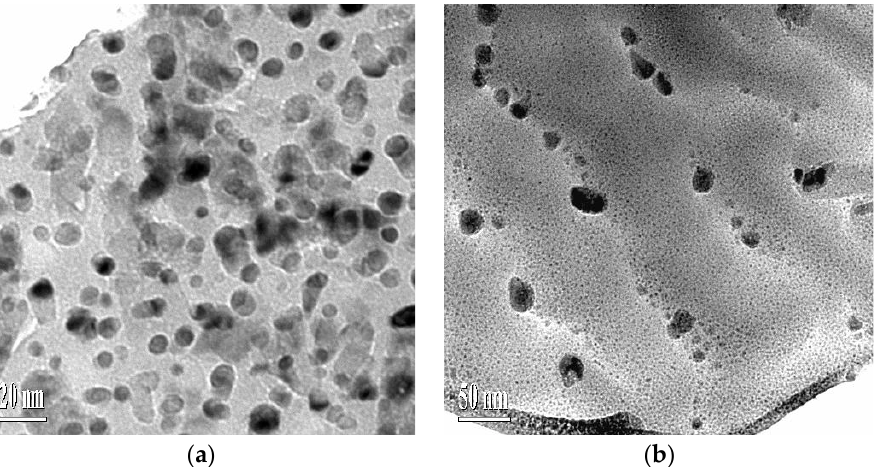
Figure 3. TEM morphology of Ti75Zr11Si9Fe5 (At %) and Ti66Zr11Si15Fe5Mo3 (At %): ( a ) TEM morphology of Ti75Zr11Si9Fe5 (At %) and Ti66Zr11Si15Fe5Mo3 (At %): Ti75Zr11Si9Fe5 (At %) and ( b ) Ti66Zr11Si15Fe5Mo3 (At %). ( a ) Ti75Zr11Si9Fe5 (At %) and ( b ) Ti66Zr11Si15Fe5Mo3 (At